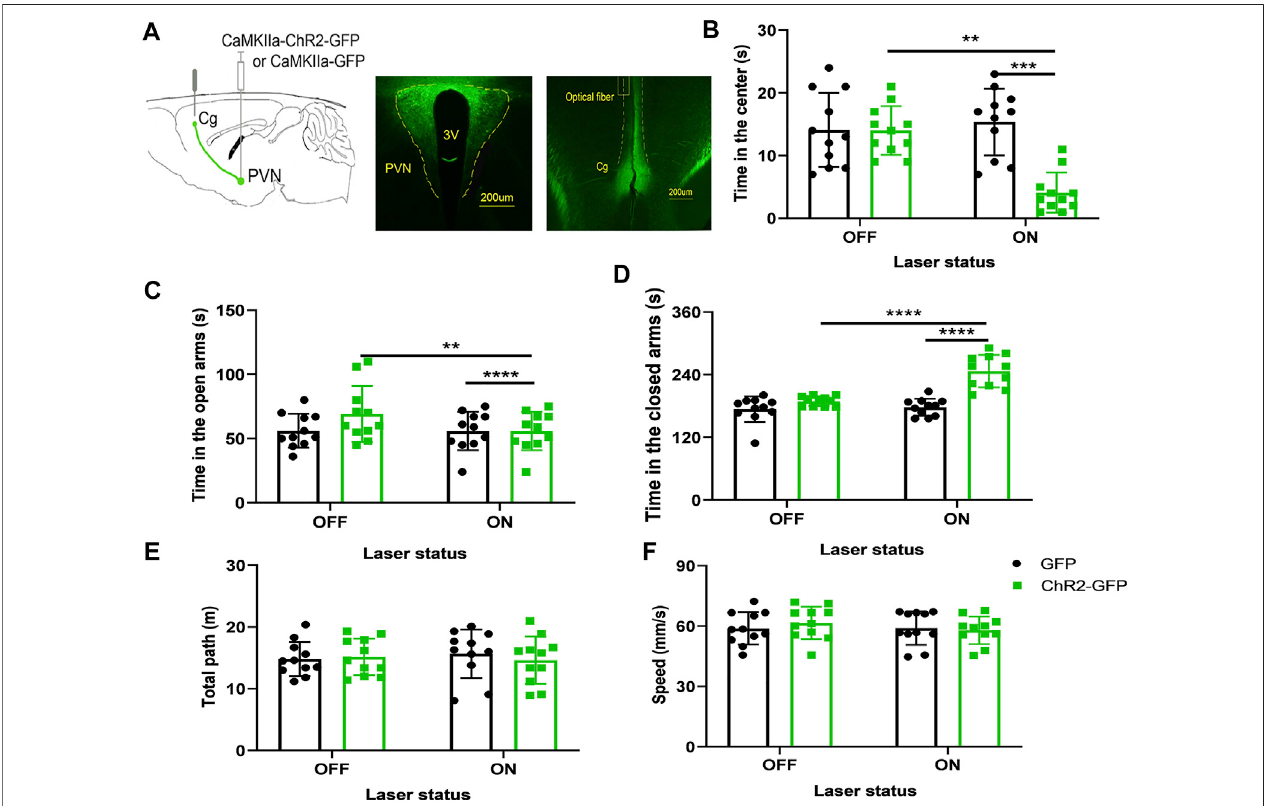
FIGURE 3 | Optogenetic activation of the PVN-Cg neural circuit increases anxiety-like behaviors in mice. (A) The image showed the expression of the ChR2-GFP virus in PVN and ChR2-expressing glutamatergic terminals in the Cg. (B) Optical stimulation of PVN efferents in the Cg decreased the time in the center in the open- fi eld test. (C) OpticalstimulationofthePVNterminalsintheCgdecreasedtheopen-armstimeintheEPMtest. (D) OpticalstimulationofthePVNefferentsintheCgincreased theclose-armstimeintheEPMtest. (E) OpticalstimulationofthePVNefferentsintheCgdidnotaffectthemovingdistanceofthemice. (F) Opticalstimulationofthe PVN efferents intheCgdid notaffectthespeedofthemice (* p < .05, ** p < .01, *** p < .001, n =11/group.Errorbars denoteSEM.Two-way repeatedmeasures ANOVA was performed followed by Bonferroni ’ s post hoc comparisons).